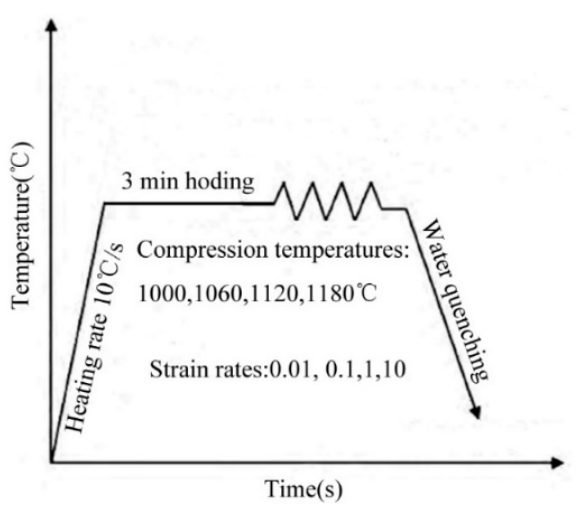
Figure 1. Experimental process.